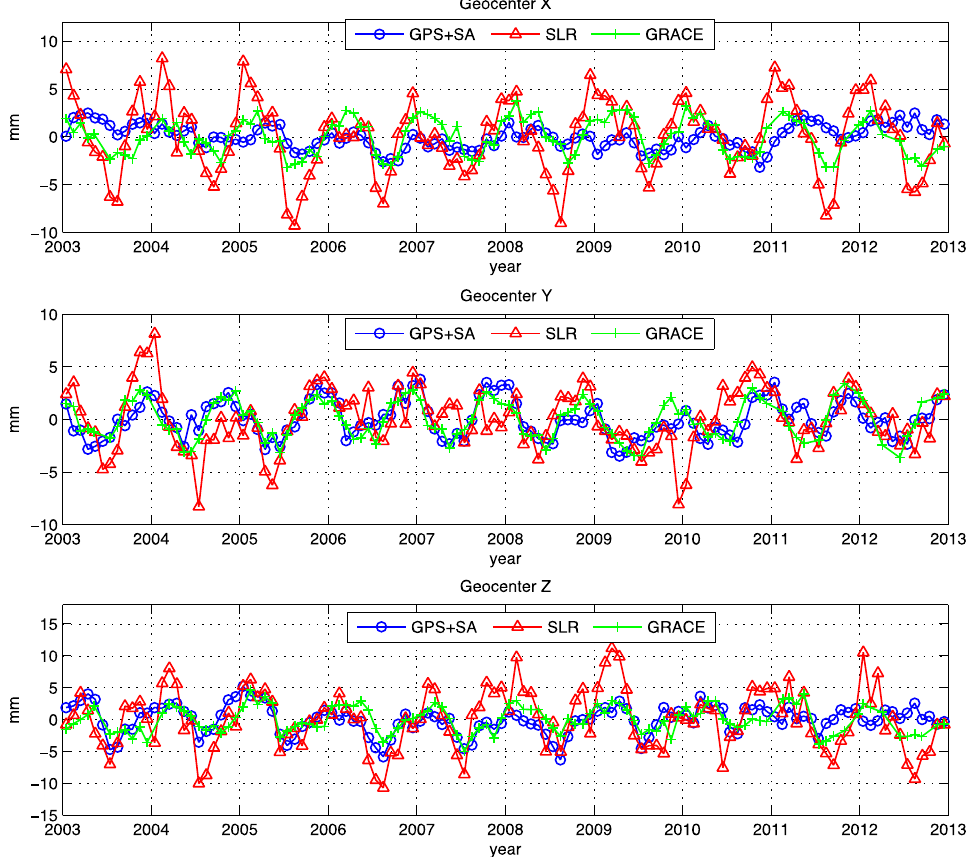
Figure 4. Geocenter time series estimated from GPS+SA, SLR and GRACE. GPS+SA shows the results from combining GPS and SA. GRACE geocenter is computed by combining GRACE and the OBP model [38].